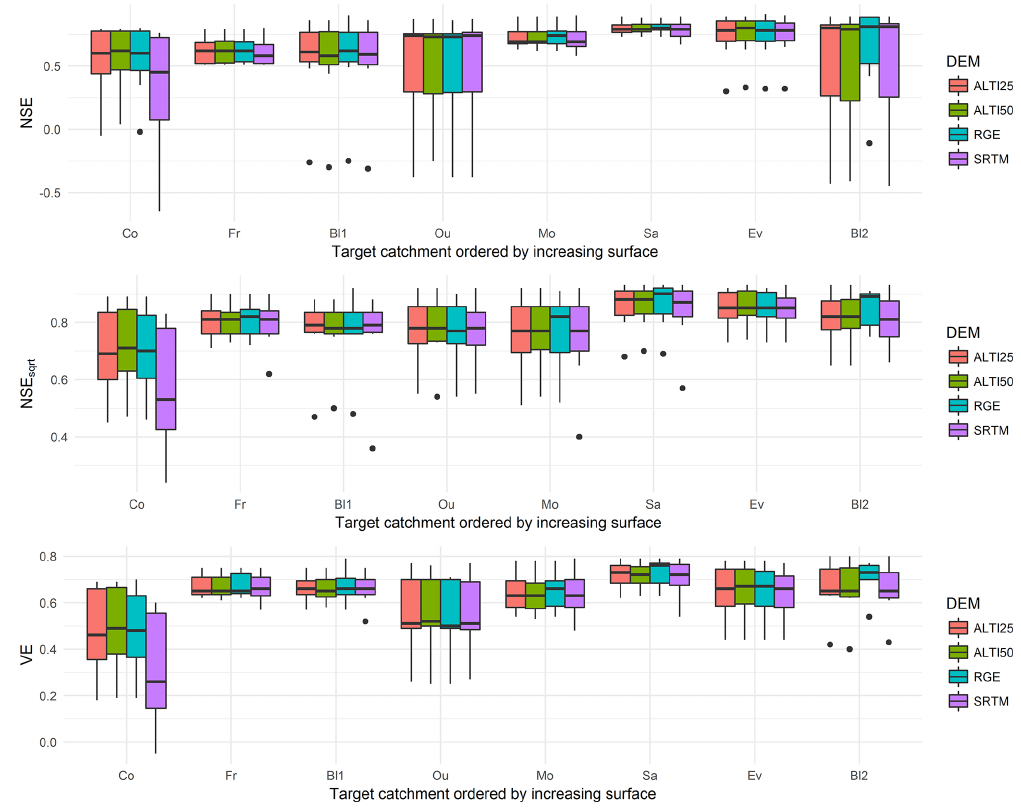
Figure 4. Simulation performance for 3 criteria and 4 DEMs, for all basins, and from all donor